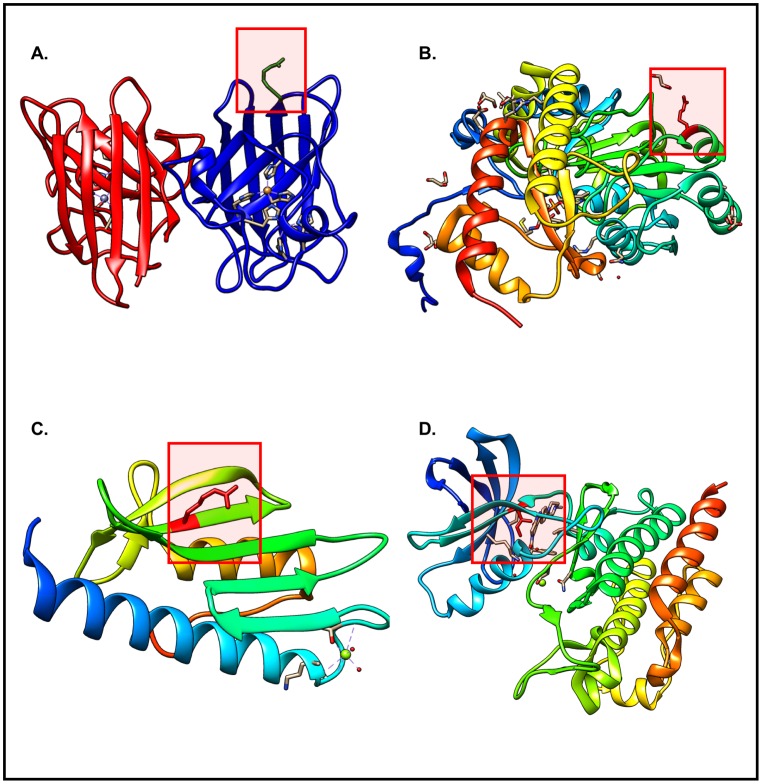
SNV consequences map to various locations within protein structures.A) PDB: 1AZV, SNV: rs121912431 (G37R) is present on the surface of the protein in the highlighted Loop segment, where it causes the neurological disease Lou Gehrig’s disease. B) PDB: 1J04, SNV: rs121908529 (G170R) is present on the surface of the protein in the highlighted Alpha_helix, where it causes hereditary kidney stone disease primary hyperoxaluria type 1. C) PDB: 3S5E, SNV: rs138471431 (W155R) is present on the surface of the protein in the highlighted Beta_sheet, where it causes the neurodegenerative disease Friedreich’s ataxia. D) PDB: 2V7A, SNV rs121913459 (T315I) is present in the ATP-binding domain and causes resistance to the drug imatinib in patients with chronic myelogenous leukemia.